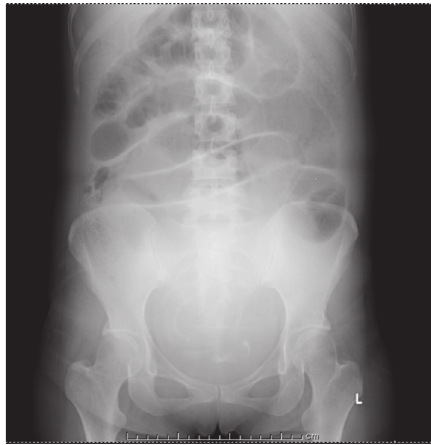
Figure 1: Abdominal X-ray showed air-fluid level of small intestine and dilated intestine.